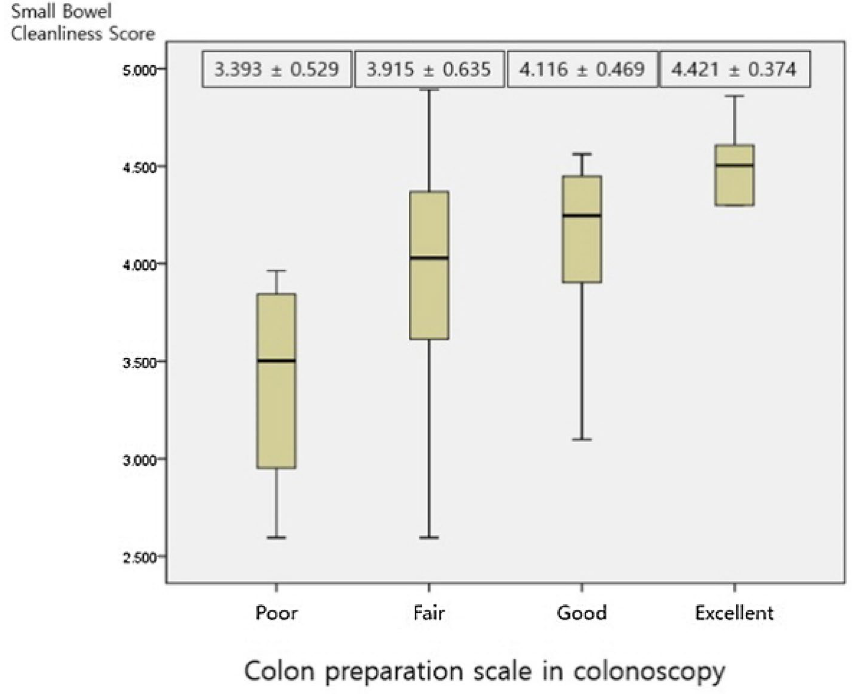
Figure 3. Colon preparation scale in colonoscopy and small bowel cleanliness scores. The colon preparation scale was measured by Aronchick Scale (from inadequate to excellent). The colon preparation was better, the small bowel cleanliness score was higher (p =